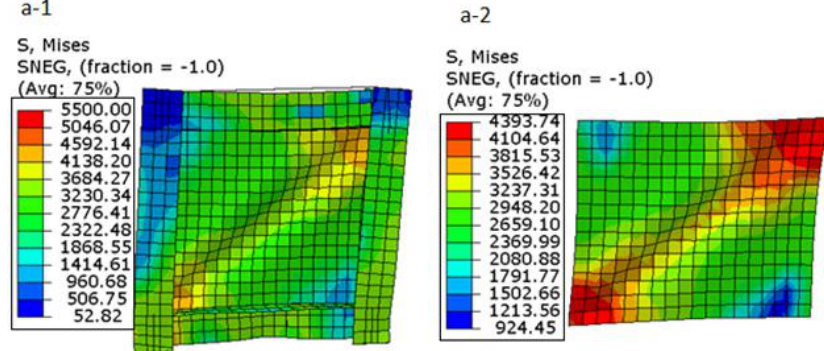
Figure 8. Von Mises stress for shell part (a-1) frame part and (a-2) steel plate.